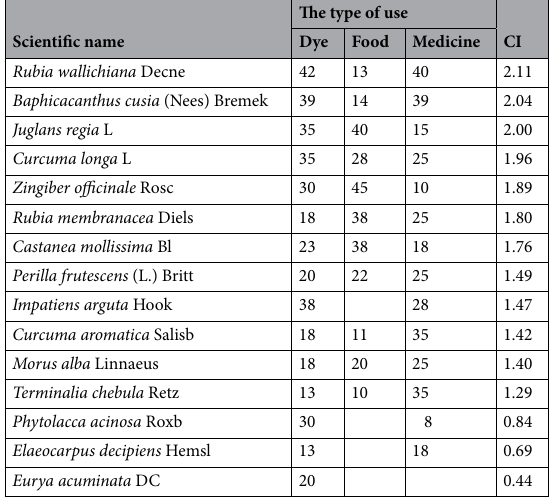
Table 2. Cultural importance index of dye plants used by Monpa